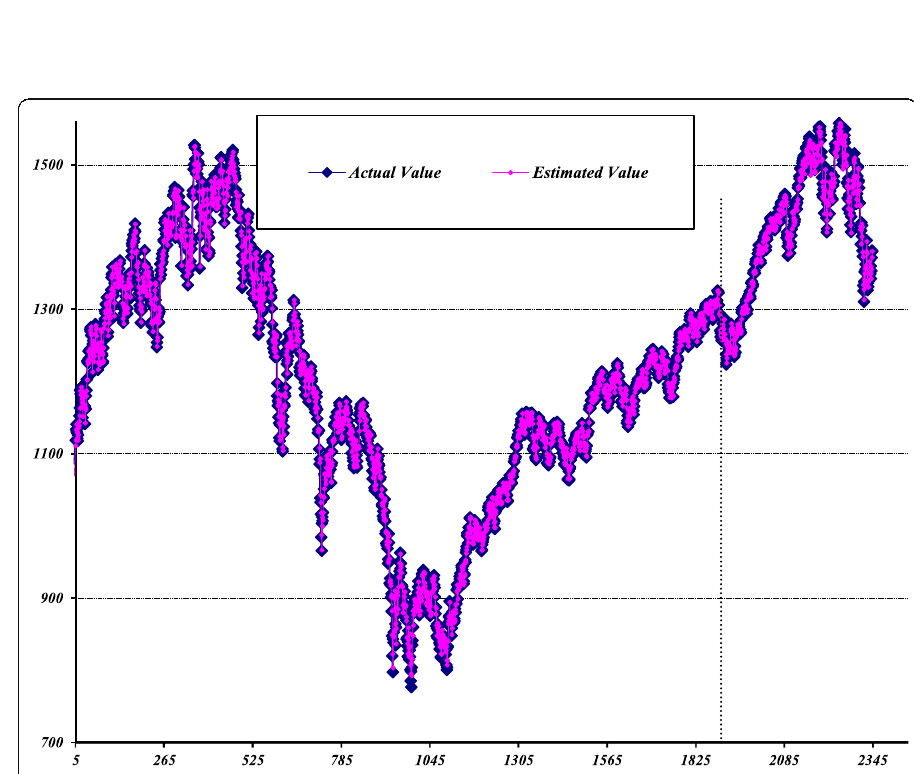
Fig. 14 Estimated values of GA-based hybrid model for S&P